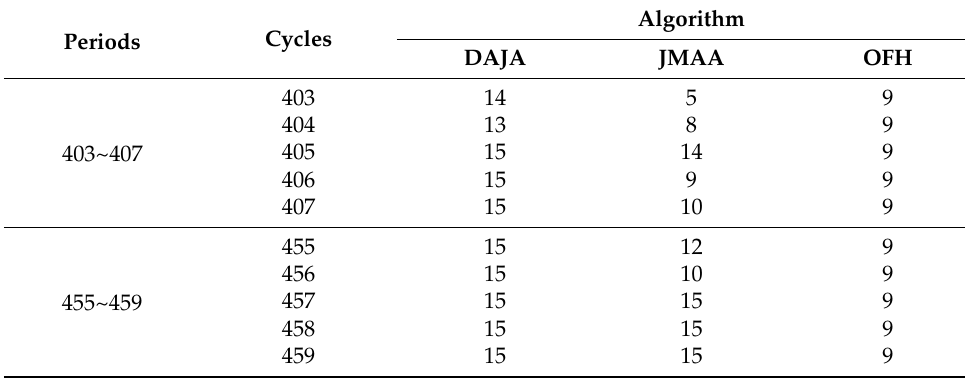
Table 2. ARTEC in different timeslot periods among mentioned algorithms. Periods Cycles